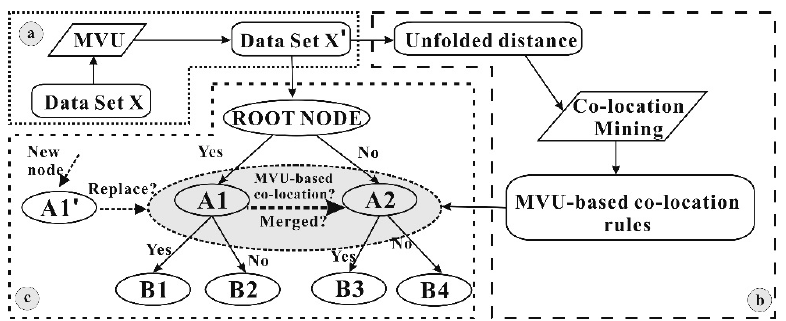
Figure 2. Maximum variance unfolding (MVU)-based co-location decision tree (MVU-based CL-DT) induction method.